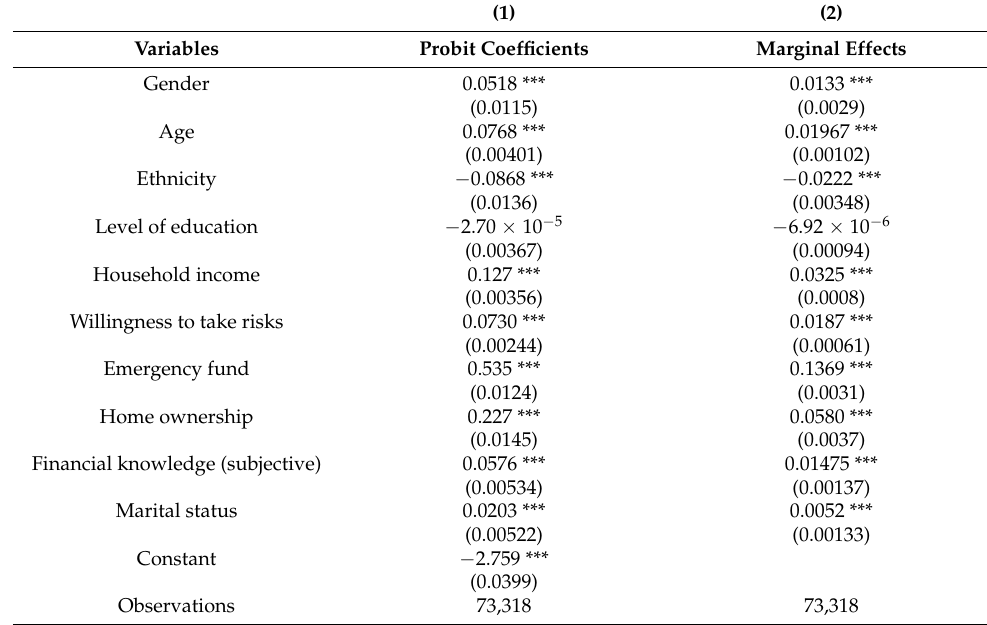
Table 5. Probit model with original data (subjective financial knowledge variable